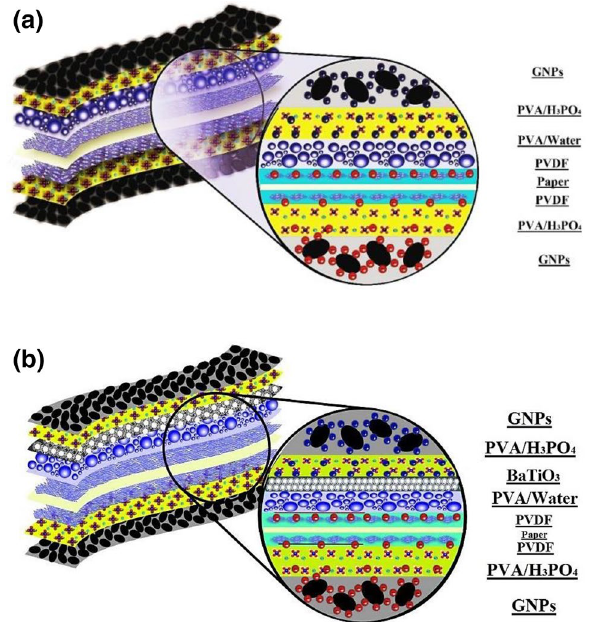
Fig. 6 Schematic of the paper supercapacitor with the structure of